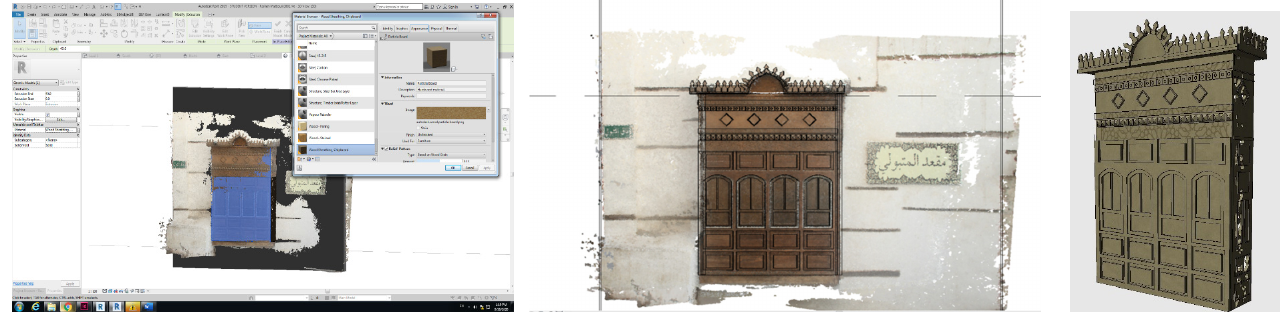
Figure 21. The Roshan was created as a parametric family using the enhanced point cloud.